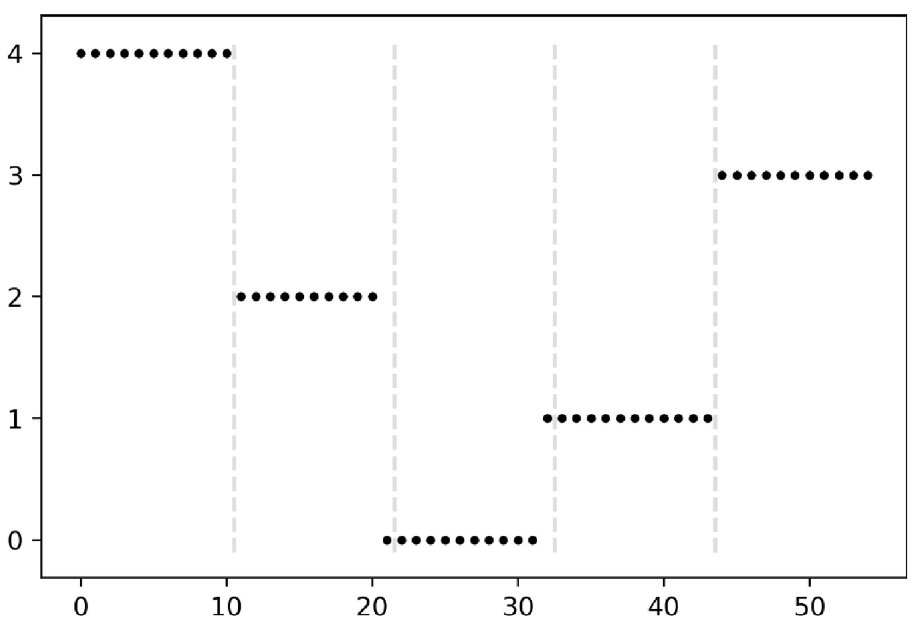
Fig 6. Scatterplot of news characteristics clustering analysis for each level of league organizations. Note: The order of the data in the figure is consistent with the order of the data samples in Table 6. The numbers 0,1,2,3,4 on the vertical axis of the image are only the classification markers obtained from clustering and have no other